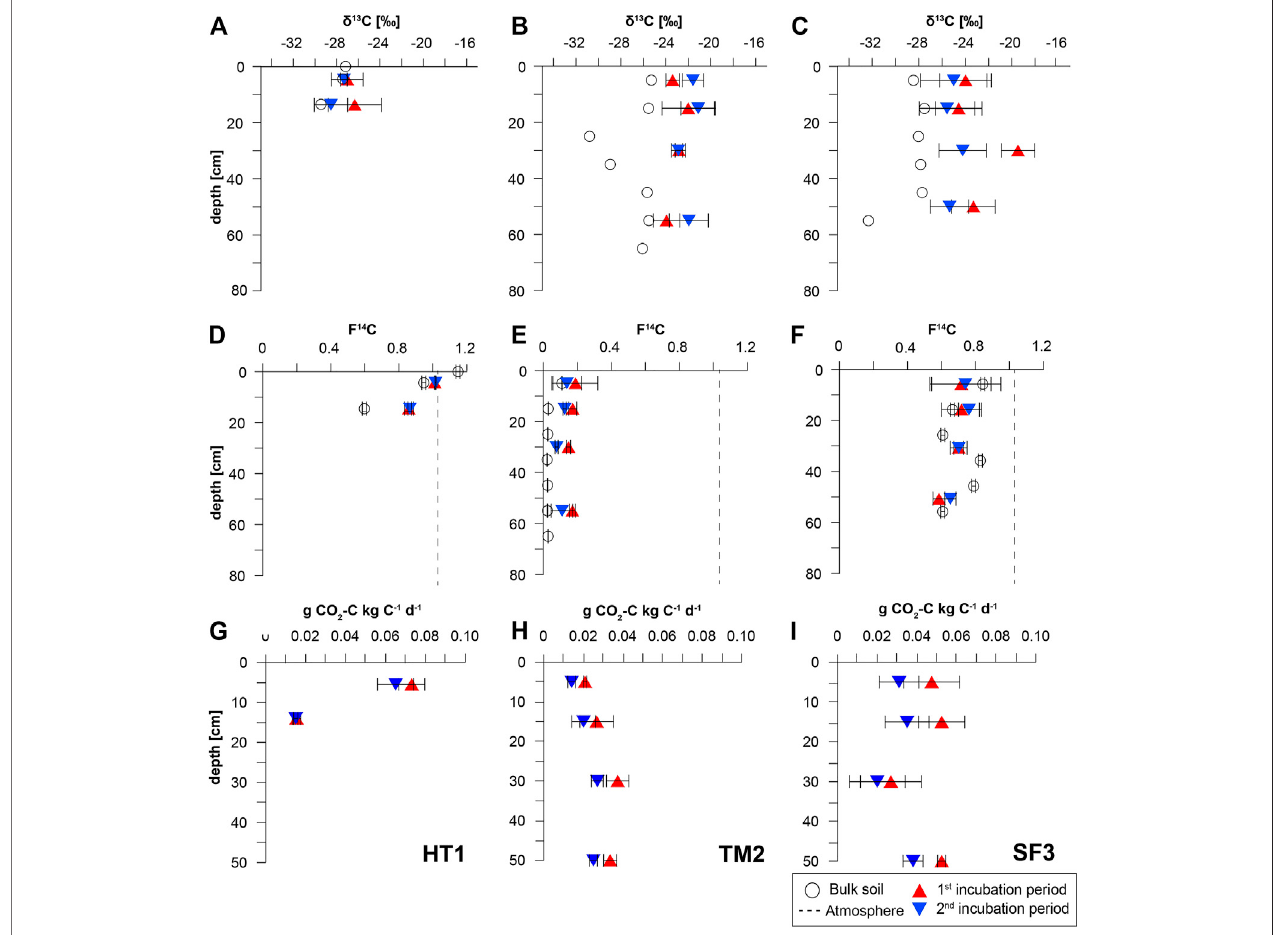
FIGURE 2 | δ 13 C (A – C) and 14 C contents (D – F) of bulk soil OC of the different sampling sites as well as CO 2 released from the incubation experiment (G – I) during the fi rst (red triangles) and the second incubation period (blue triangles) normalized to the amount of soil